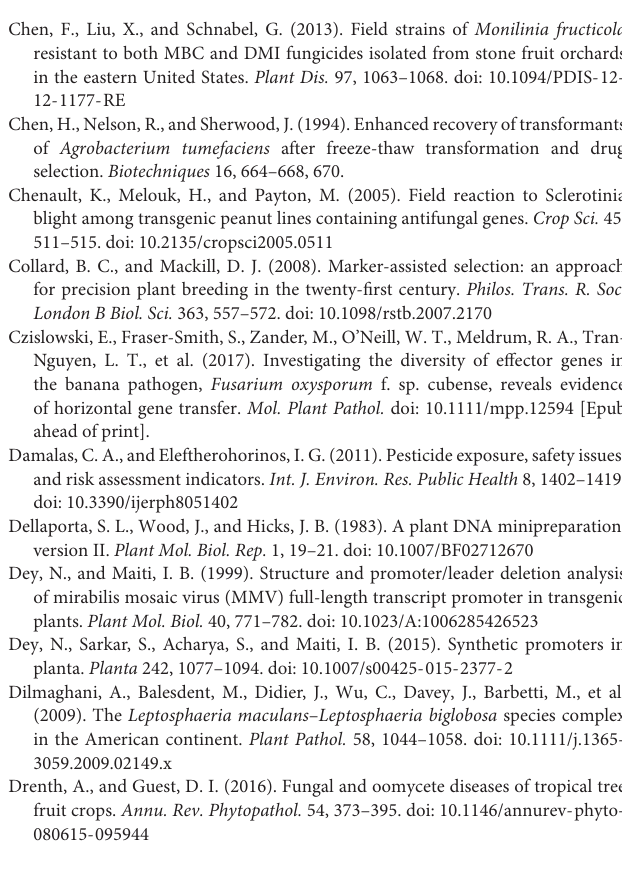
TABLE S1 | List of oligonucleotides (primers) used in this study. ∗ The annealing temperature for all the above PCR/Real Time PCR primer sets was 58 ◦ C. TABLE S2 | Segregation analysis of T 1 generation plants expressing